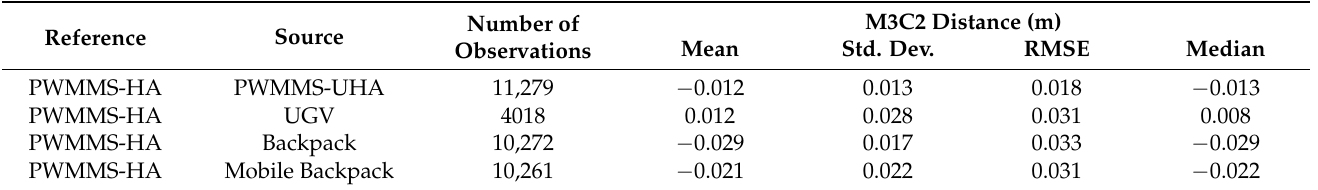
Table 9. Discrepancy estimation based on M3C2 distance using A-1 (UAV), A-2 (PWMMS-HA), and A-3 (Mobile- pack)